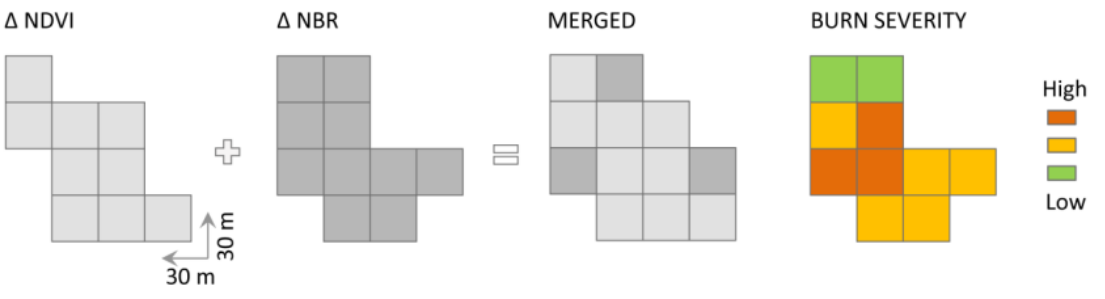
Figure 3. Graphic scheme of the GIS analysis to detect the burned areas. The polygons deriving from the ΔNDVI and ΔNBR analysis were merged. As illustrated in the right-hand image, burn severity was assessed only for the ΔNBR data. NBR, Normalized Burn